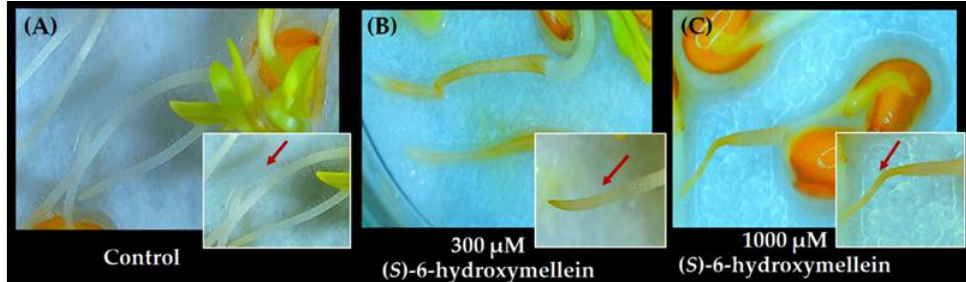
Figure 5. Effects of ( S )-6-hydroxymellein isolated from the S. garrettiana leaf extracts on the piliferous root zone of L. sativum after 48 h of treatment. Control exhibits abundant root hairs ( A ); ( S )-6- hydroxymellein at 300 µM ( B ) and 1,000 µM ( C ) triggered root necrosis and loss of root hairs.